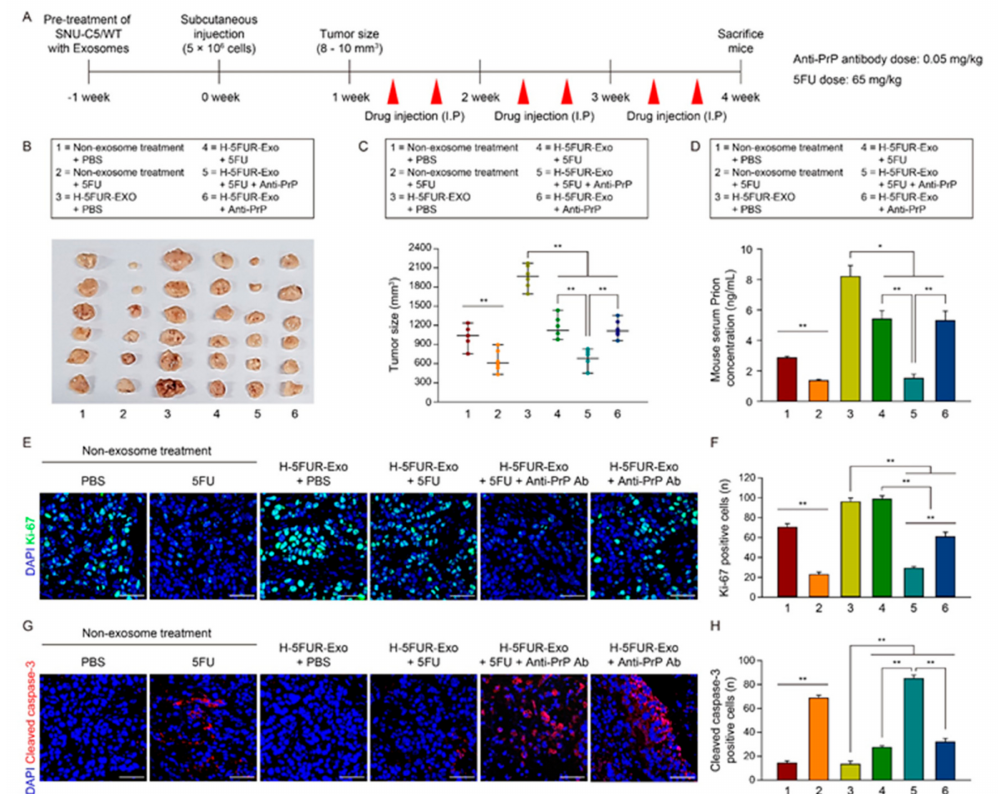
Figure 7. Effect of co-administration of anti-PrP antibody and 5FU in a murine xenograft model treated with exosomes secreted by hypoxic CRC cells. ( A ) Schematic illustration of SNU-C5/WT cells pretreated with/without H-5FUR-Exo in vivo subcutaneous transplantation and injection with PBS, 5FU, 5FU + anti-PrP antibody, and anti-PrP antibody. ( B ) Photographs of tumor growth in a murine xenograft mouse model. ( C ) Quantification of tumor size in each group ( n = 6). ( D ) ELISA analysis of PrP C expression in sera isolated from a murine xenograft model ( n = 6). ( E ) Representative immunofluorescence staining analysis of Ki-67 (green) in colorectal cancer tissues. Scale bar = 50 µ m. ( F ) The graph shows Ki-67-positive cells in tumor tissues ( n = 3) ( G ) Representative immunofluorescence staining analysis of cleaved caspase-3 (red) in colorectal cancer tissues. Scale bar = 50 µ m. ( H ) The graph shows cleaved caspase-3-positive cells in tumor tissues ( n = 3). Data are presented as the mean ± SEM. * p < 0.05, ** p < 0.01